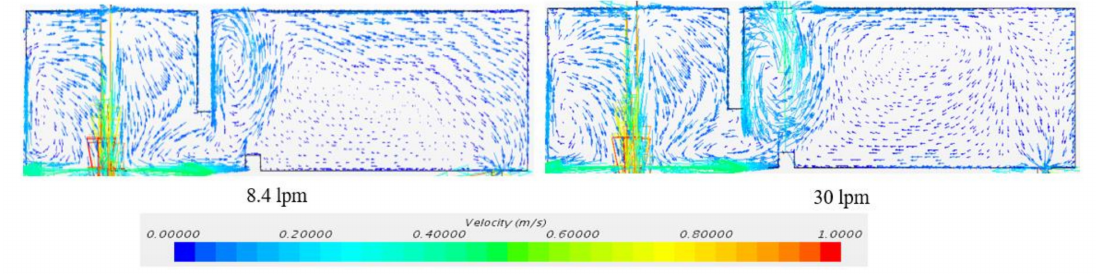
Figure 10. The e ff ect of the gas flow rate on the flow pattern (Case 3-W + LD + G).